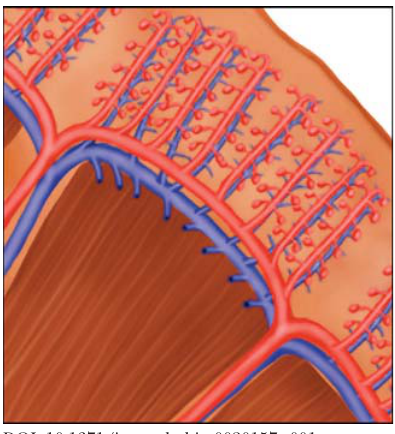
The rich visuals and moving media of this Virtual Labs animation capture the attention of the students. (The animation can be accessed online on computers with Shockwave by clicking and dragging the fi le into the browser window. A free version of Shockwave can be downloaded from